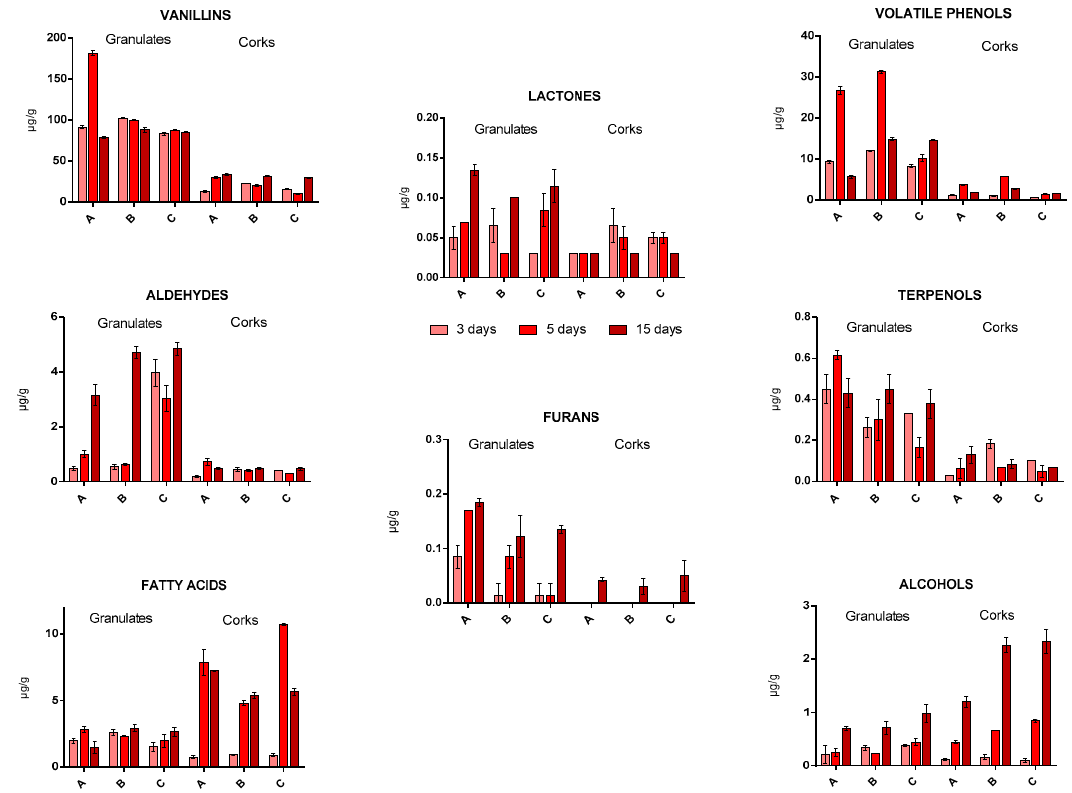
Figure 3. Composition per family of the studied aromatic compounds. Different particle size from cork stoppers and their respective granulates (A; high, B; medium, C; small).